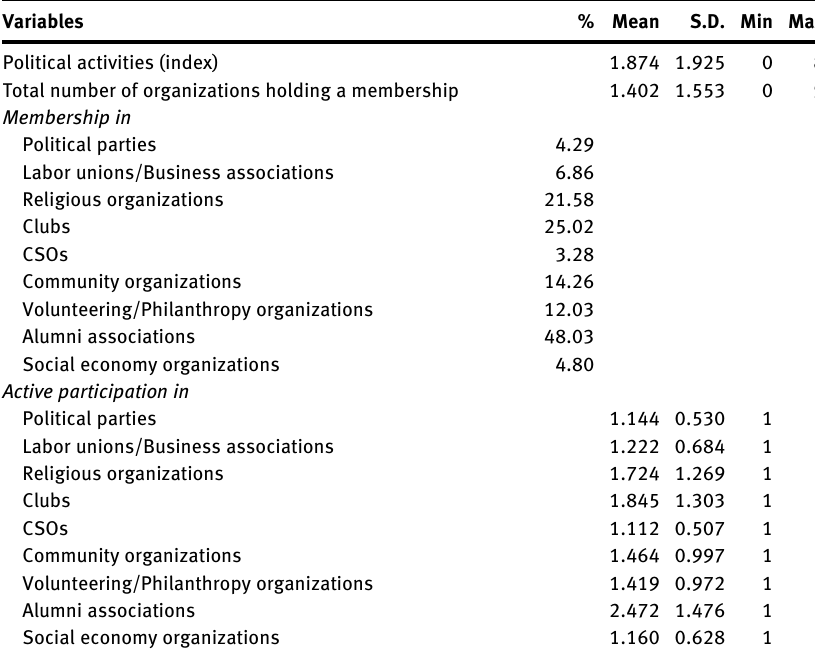
Table  : Descriptive statistics of the variables ( N =  , 